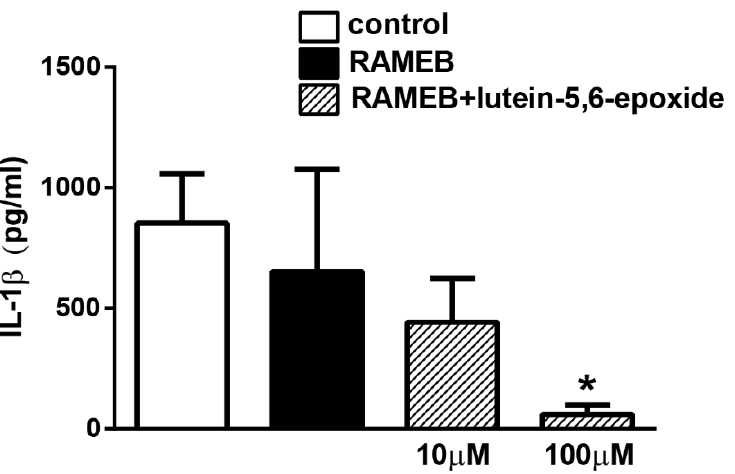
Figure 5. Activity of RAMEB-lutein 5,6-epoxide on lipopolysaccharide-(LPS)-induced IL-1 β production. Concentration of IL-1 β inflammatory cytokine in peritoneal macrophage cell culture supernatant after LPS stimulation was significantly decreased upon higher dose (100 µ m) RAMEB+lutein-5,6-epoxid treatment. N = 3. * p < 0.05, (vs. LPS treated cells, One-way ANOVA, Tukey’s post hoc test).